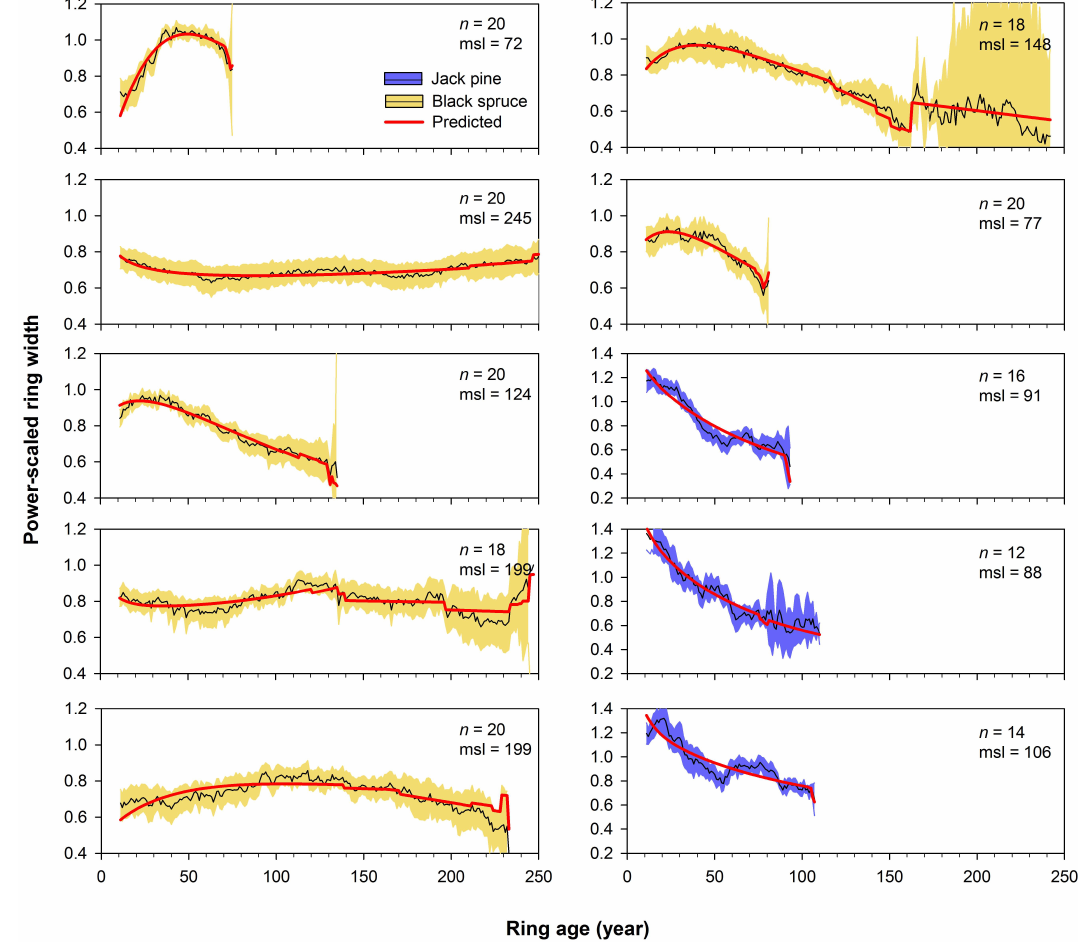
Fig. 1. Plot-level black spruce and jack pine sample-average tree-ring width versus ring age for a subset of the 252 plots under study. The tree-ring width measurement series were rescaled using a power transformation method for elimination of heteroscedasticity. Shaded area shows 90% confidence interval associated with the sample-average. Total number of samples ( n) (divide by two for the number of trees) and mean sample length (msl in years) are indicated. Also plotted are the sample-average exponential fits used in the detrending procedure of the tree-ring width measurement